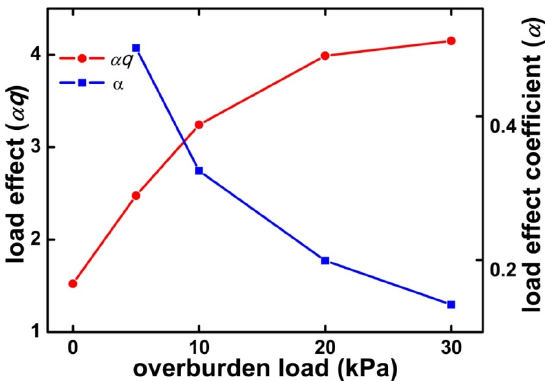
Figure 11. Plot of the overburden load effect and effect coefficient versus overburden load.